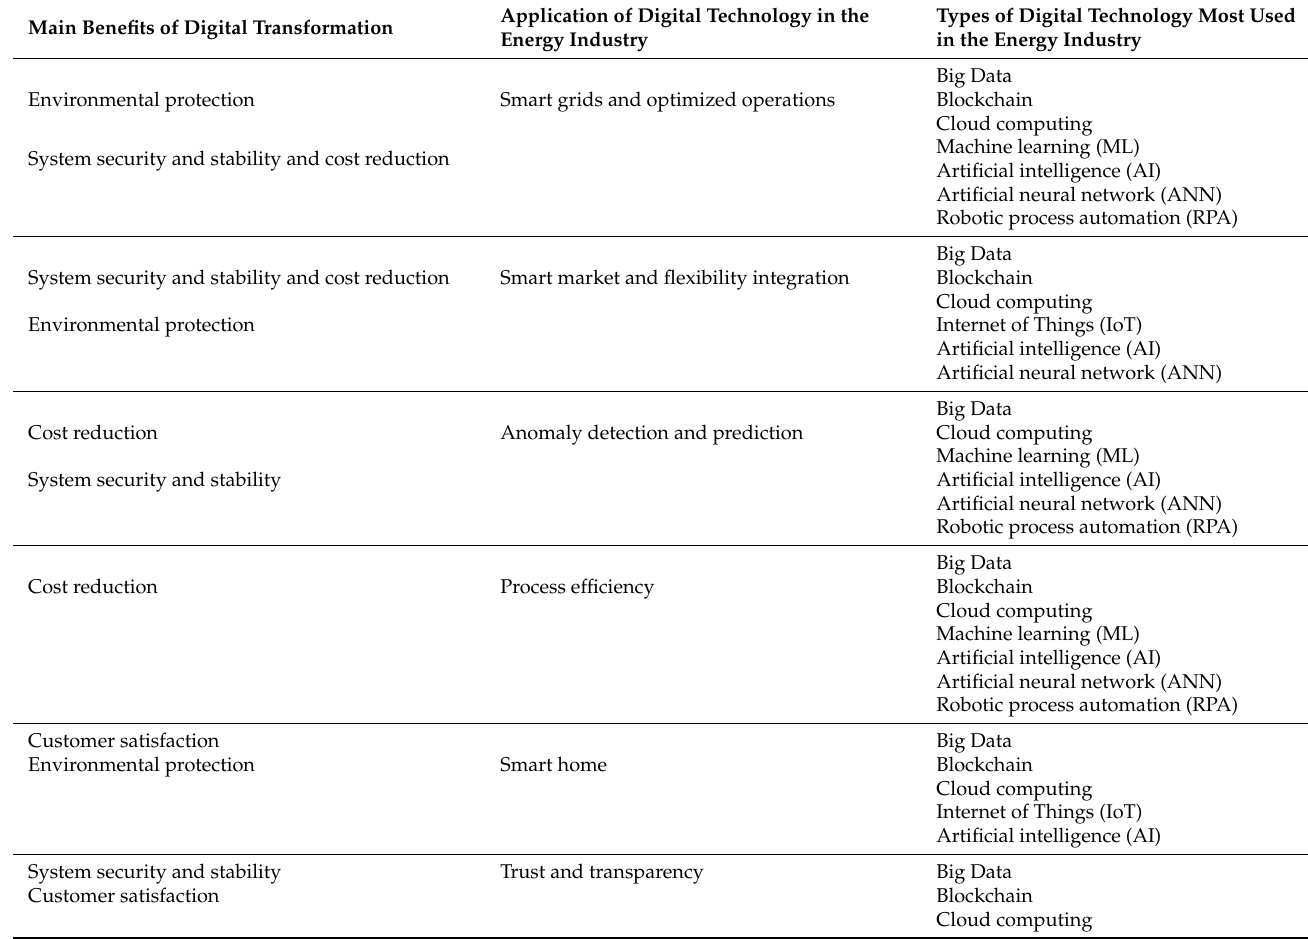
Table 5. Digital applications and their use and benefits in the energy sector